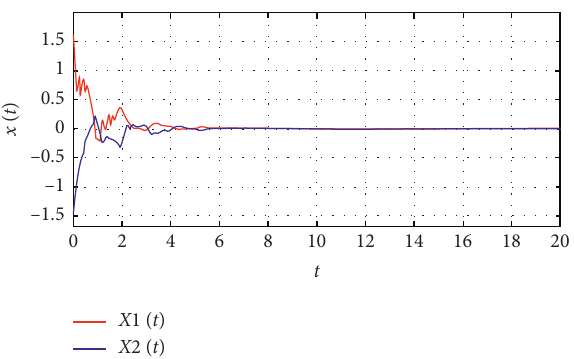
Figure 1: State 1 response curve.